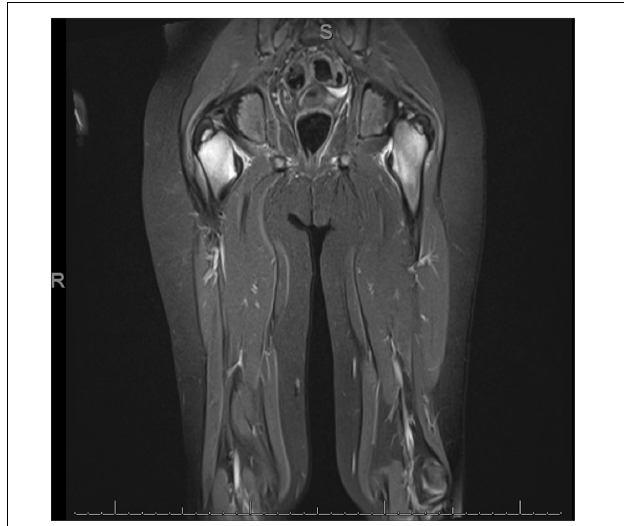
FIGURE 1 | Magnetic resonance image of the patient’s bilateral lower extremities. Image demonstrates decreased T1 and increased T2 signal abnormality in the intertrochanteric femora bilaterally, right slightly greater than